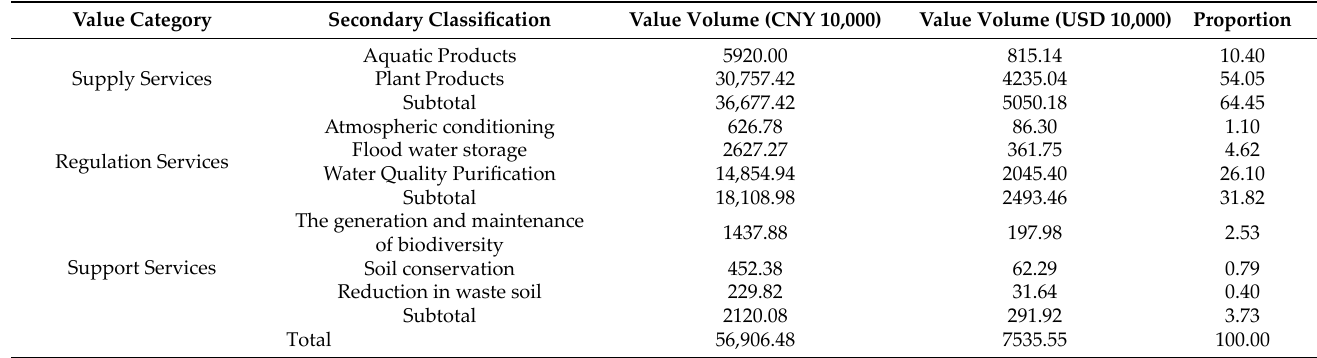
Table 4. Value of ecological products in the Qilihai